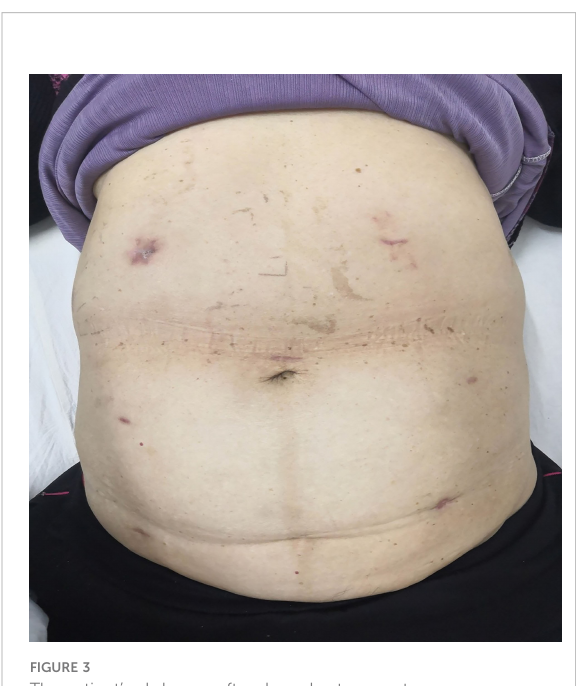
FIGURE 3 The patient ’ s abdomen after dermal sutures out.